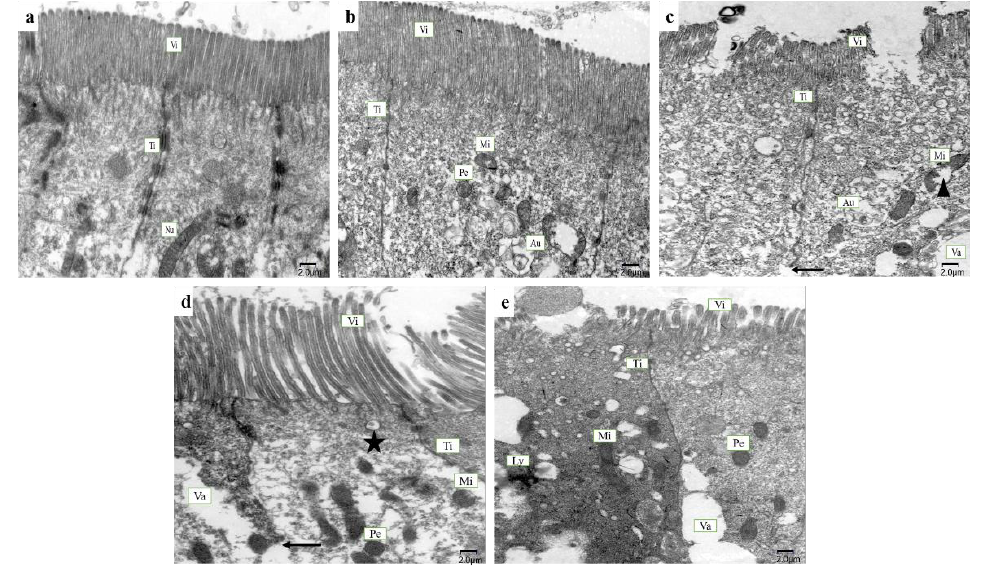
Figure 2. Ultrastructure of posterior intestinal cells of hybrid yellow catfish fed with different glycinin levels under electron microscope. Intestinal villi from fish of control group showing neat arrangement ( a ). Posterior intestine from fish of 2% glycinin group have clear tight junctions be- tween enterocytes, with abundant organelles ( b ). However, posterior intestine from fish of 4% glycinin group showing mild microvesicular vacuolation and intestinal villous striated margin shedding, as well as mitochondria damage (triangle) and broken tight junction (arrow) ( c ). Entero- cytes from fish of 6% glycinin group displaying moderate vacuolation, with cytoplasmic transpar- ency, as well as loose intestinal villi and broken tight junction (arrow) ( d ). Intestinal villi from fish of 8% glycinin group disorganized and enterocytes appearing serious vacuolation ( e ). Five-pointed star indicating fusion morphology of secondary lysosome and phagocytic vesicles. Vi, intestinal villi; Ti, tight junction; Nu, nucleus; Mi, mitochondria; Pe, peroxisome; Au, autolysosome; Va, vac- uolation; Ly, lysosome. The scale represents 2 μm. Microstructural observations showed that livers from juvenile hybrid yellow catfish fed with high-level glycinin were obviously damaged (Figure 3). The liver cell had a uni- form size shape, with clear cell boundaries and central nuclei in the control group (a). However, liver cells of fish treated with 2% and 4% glycinin exhibited lipid vacuoles and a disorganized nucleus (b,c). Dietary 6% and 8% glycinin were accompanied by typical features of steatosis and injury of liver cells, including nuclear dissolution, nuclear shrink- age and nuclear offset. The number of lipid vacuoles also increased and the number of liver cells decreased compared with the control group (d,e).